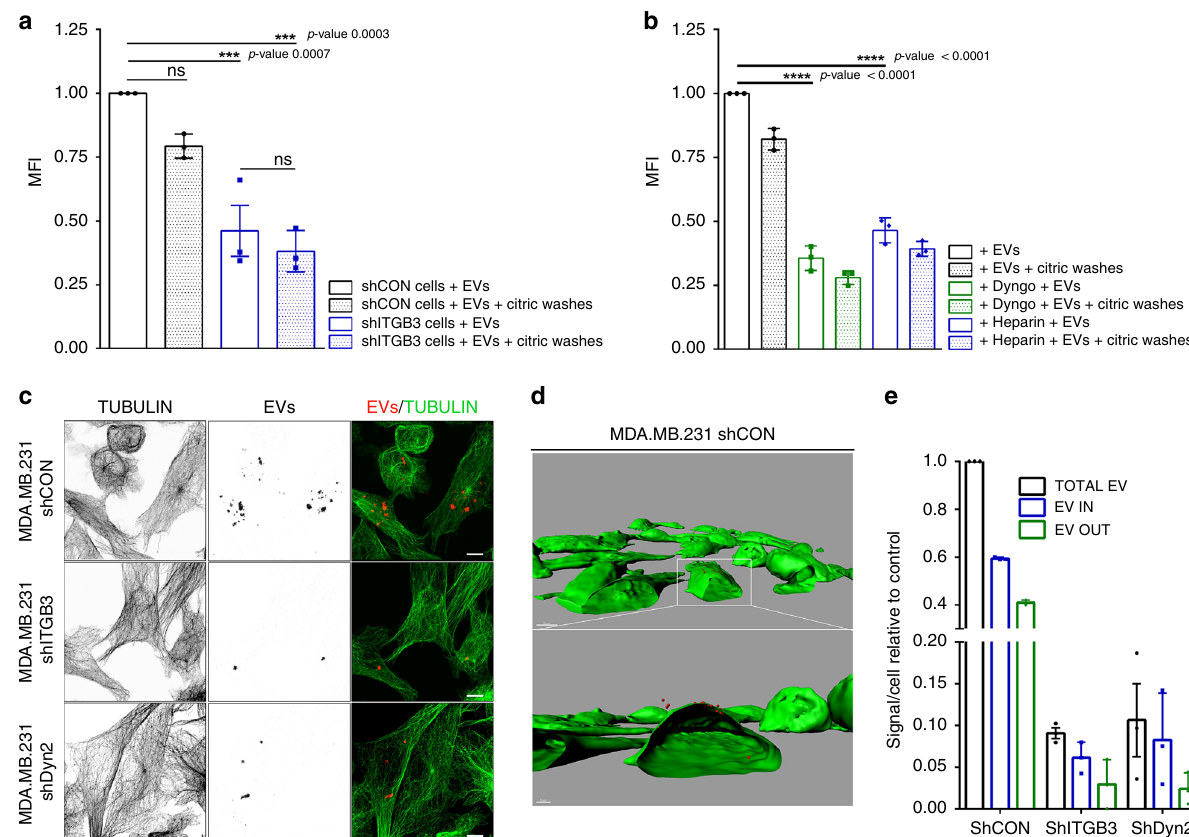
Fig. 3 Interaction of EVs with the cell surface is a highly dynamic process. Internalization of 2 – 5 µ g mL − 1 PKH26-labelled EVs derived from MDA. MB.231 cells by MDA.MB.231 shCON or MDA.MB.231 shITGB3 cells, measured by FACS. a Uptake of vesicles was measured by FACS after subjecting the cells to acid washing. b Internalization of 2 – 5 µ g mL − 1 PKH26-labelled EVs derived from MDA.MB.231 cells by MDA.MB.231 WT cells, pretreated with 20 μ M Dyngo4a and pre-treated with 10 μ g mL − 1 heparin, with or without subjecting the cells to acid washing. c Representative confocal pictures used for 3D reconstruction. d Representative 3D reconstruction picture of MDA.MB.231 shCON cells. Bar represents 5 µ m. e Analysis of EV internalization in MDA. MB.231 shCON, shITGB3 and shDyn2 cells after 3D reconstruction. Source data are provided as a Source Data fi le. (*** p value < 0.001, **** p value < 0.0001, n = 3). Data are represented as mean ± SD in ( a , b , e ). Statistical analysis including two-way ANOVA multiple comparisons was carried out using GraphPad Prism